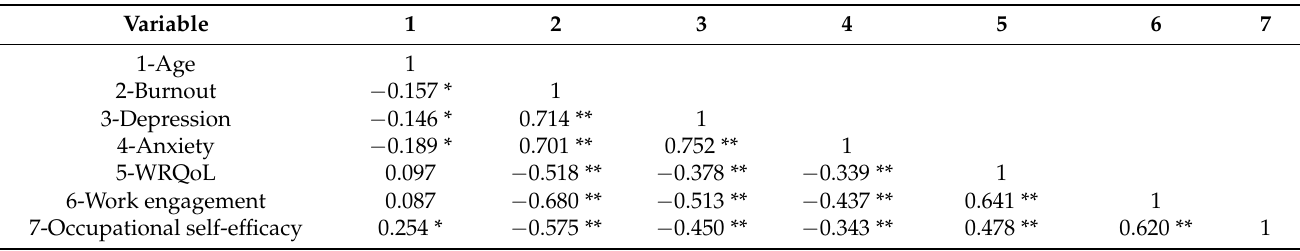
Table 3. Correlation matrix.